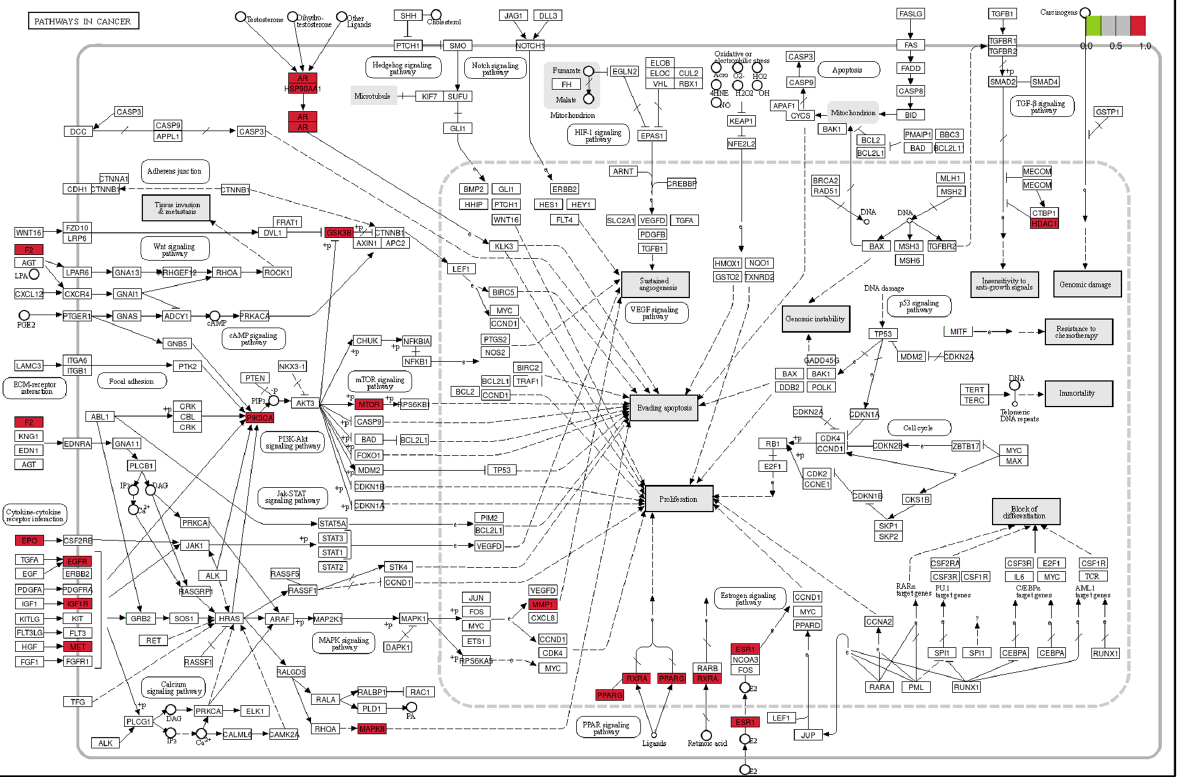
Figure 7. The map of pathways of cancer. Nodes with red color represent the major target genes of HH on liver fibrosis.